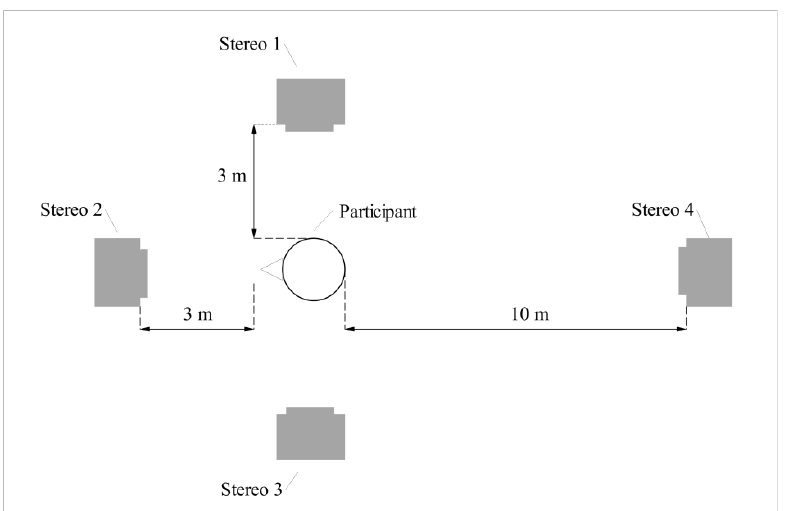
Figure 5. Experimental setting. Stereos 1–3 were used to play environmental noise, and stereo 4 was used to play warning sounds. The distance of stereo 4 from the participant could be changed according to the experimental conditions.